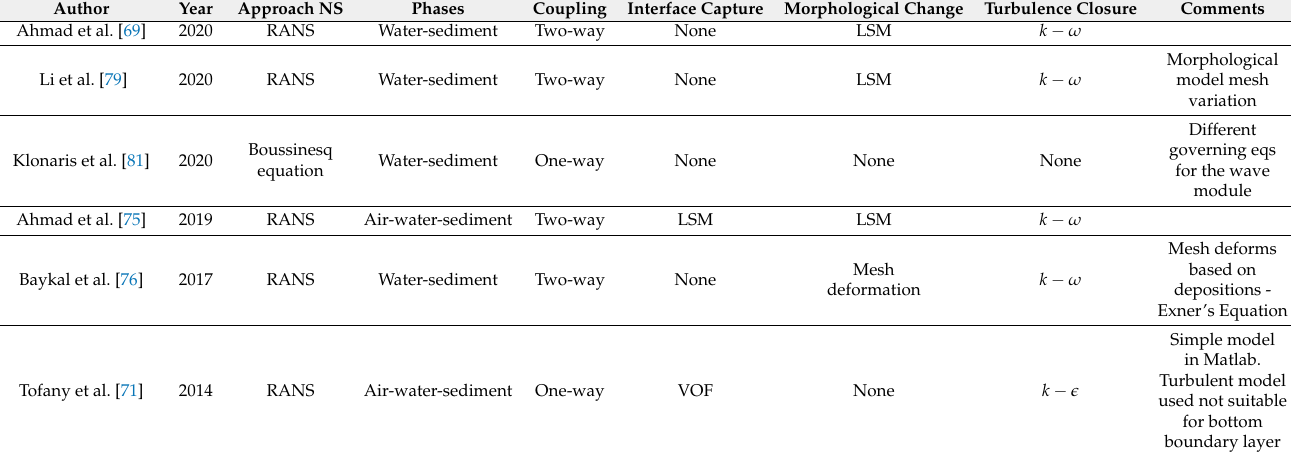
Table 1. A summary of the most recent and leading works that use the simple approach to model the wave–structure–seabed interactions.